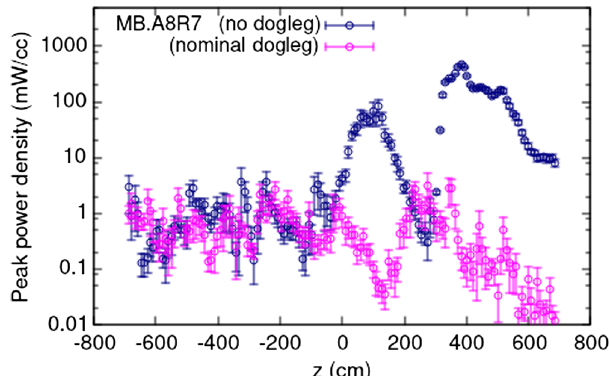
FIG. 15. Peak power density profile in the SC coils of the first main bending dipole in the DS (MB.A8R7), with and without the dogleg. Values are calculated for 0.2 h BLT and are radially averaged over the SC cable thickness. For the nominal dogleg case, they are higher than in Figs. 11 and 12 due to the additional shower contribution discussed in the text. Vertical bars, where visible, indicate the statistical